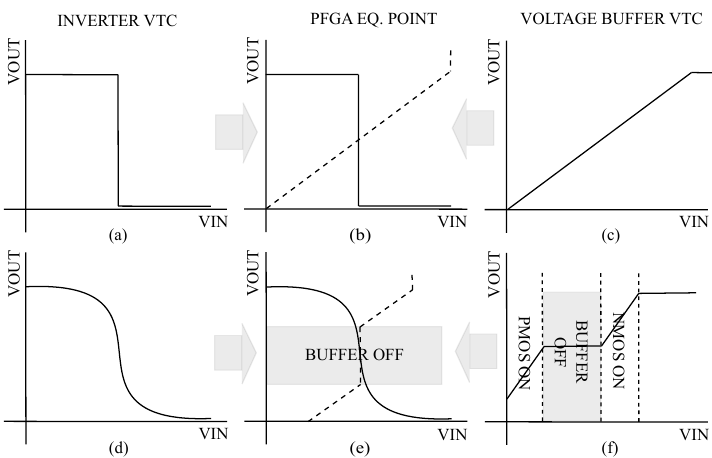
Figure 2. Graphical representation of the equilibrium point of the PFGA. ( a ) Ideal VTC (voltage transfer characteristic) curve of the inverter. ( b ) Ideal equilibrium point of the PFGA at the intersection of the two curves (continuous and dashed lines for inverter VTC and buffer VTC respectively). ( c ) Ideal VTC curve of the voltage buffer. ( d ) Real VTC curve of the inverter. ( e ) Equilibrium point of a real PFGA (continuous and dashed lines for inverter VTC and buffer VTC respectively). ( f ) Real VTC curve of the voltage